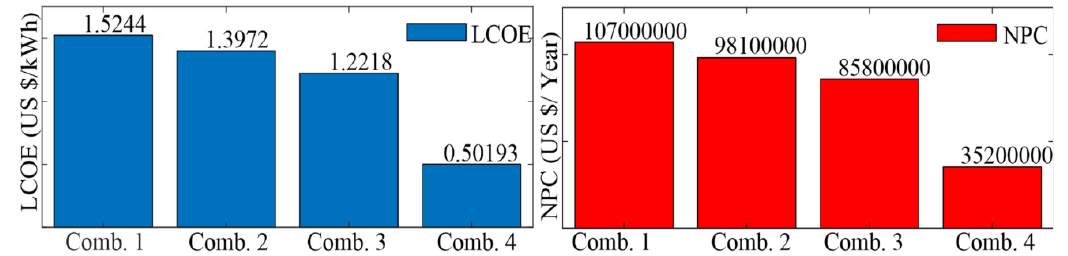
Figure 18. Comparison of LCOE and NPC: combination 1, 2, 3 & 4.